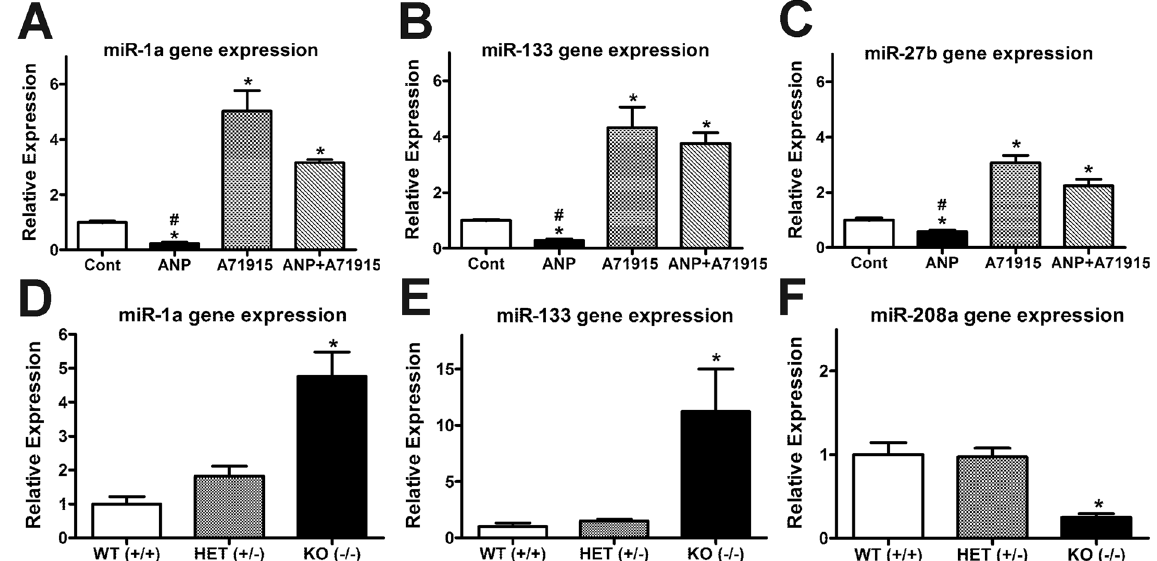
Figure 9. Effects of ANP/NPRA signaling and NPRA genotype on candidate microRNA levels in embryonic ventricles. ( A–C ) Expression analysis of miR-1a (A), miR-133 (B) and miR-27b (C) was performed on total microRNA isolated from E11.5 ventricular cell cultures treated with or without ANP (1 μ g/ml) and NPRA inhibitor, A71915 (1 µ M). MiR-1 and miR-133 target HCN4 mRNA and miR-27b regulates Cx40 mRNA levels. For all three miRNAs analyzed, addition of ANP significantly reduced expression of microRNAs, whereas addition of A71915 increased expression of microRNAs. N = 7 independent experiments. * P < 0.005 Vs. Cont, # P < 0.005 Vs. ANP or ANP + A71915, One-way ANOVA with Tukey’s post hoc test. ( D–F ) Expression analysis of miR-1a (D), miR-133 (E) and miR-208a (F) was also performed on total microRNA isolated from E14.5 ventricles of NPRA wild type (WT), heterozygous (HET) and knockout (KO) mice. Compared to WT mice, NPRA KO mice demonstrated upregulation of miR-1a (D) and miR-133 (E) and downregulation of miR-208a (F). There were no significant differences in miR-27b expression between genotypes. For all panels, microRNA expression levels were normalized using U6 levels via ∆∆ C T method. Each bar represents mean ± SEM. N = 4 independent experiments. * P < 0.05 Vs. WT and HET, One-way ANOVA with Tukey’s post hoc